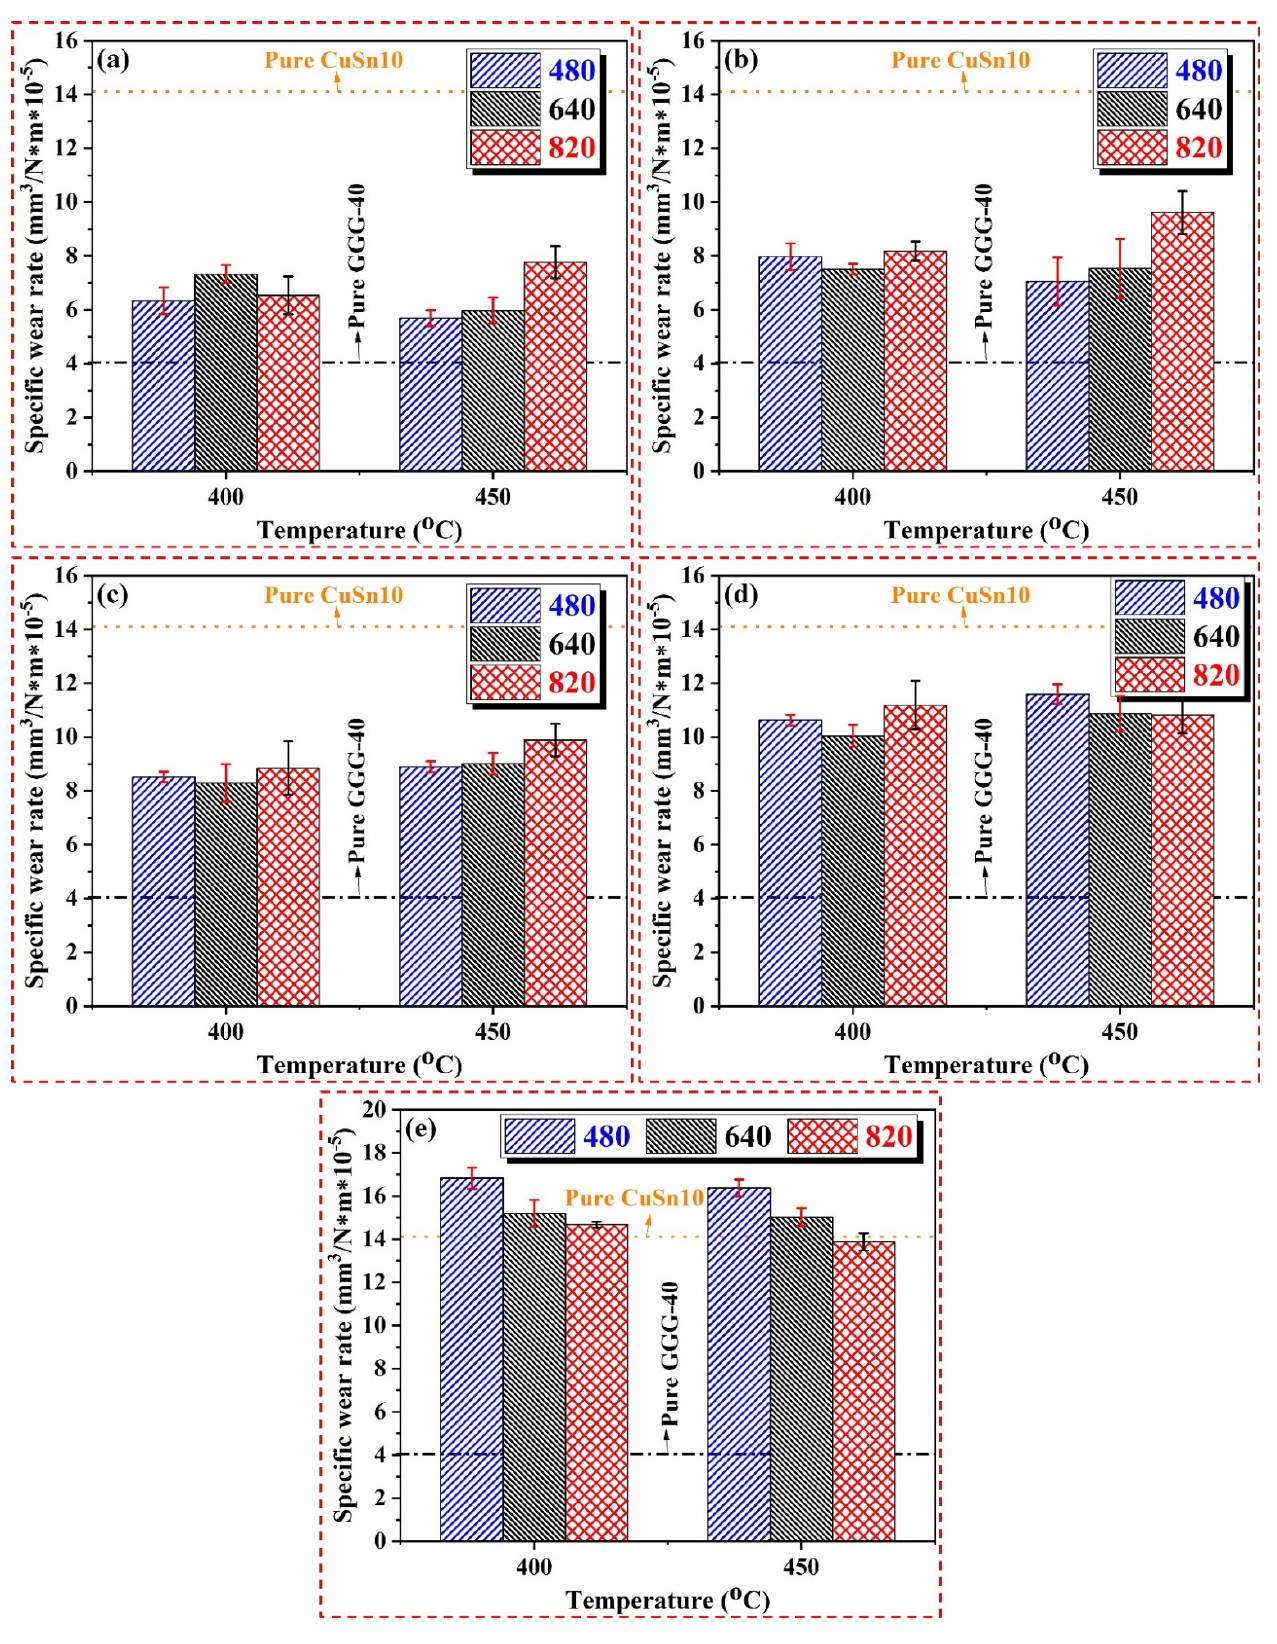
Figure 6. Specific wear rates of ( a ) 60C40G, ( b ) 70C30G, ( c ) 80C20G, ( d ) 90C10G, and ( e ) 100C samples with respect to different production parameters.